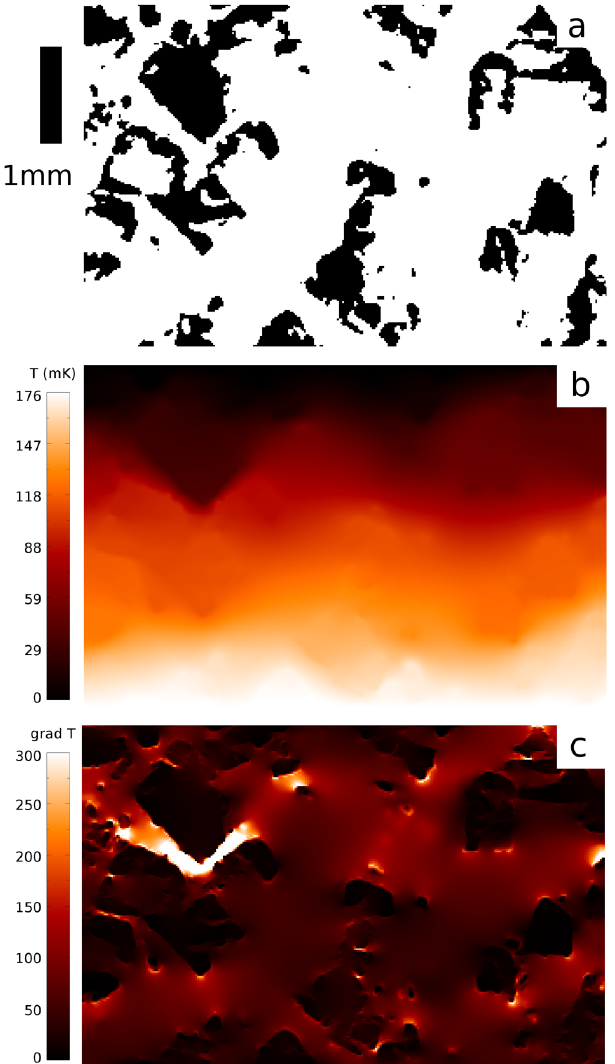
Fig. 4. Visualization of (a) the structure for one slice of Series 2, at t = 320h, (b) temperature distribution (shown in mKw.r.t. the boundary conditions; real temperature at the bottom was − 7.05 ◦ C), and (c) temperature gradient (Km − 1 ). Note that the temperature boundary conditions were equivalent to a gradient of 50Km − 1 . The coordinate system coincides with the one in Fig. 2, as well as the direction of the macroscopic temperature gradient. The physical dimensions of the slices are 3 . 6 × 5 . 4mm 2